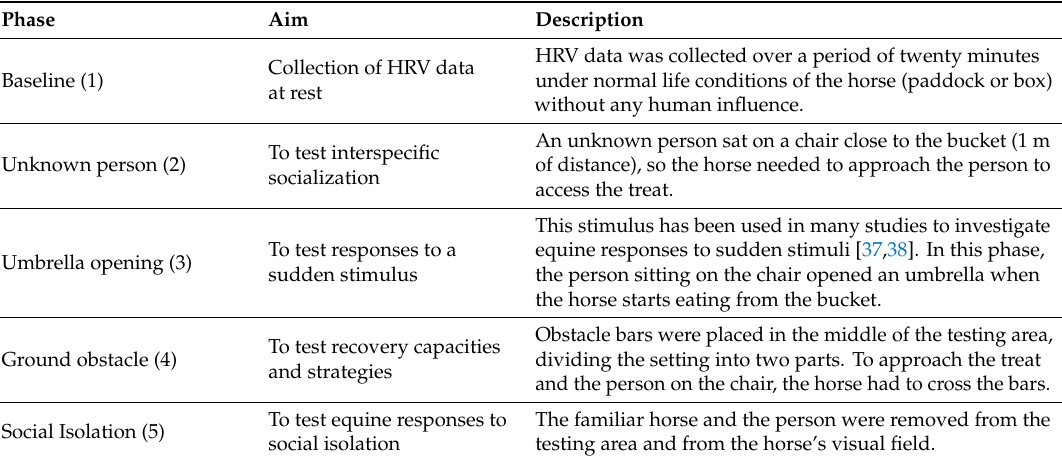
Table 1. Description of the aims of each phase of the experiment.